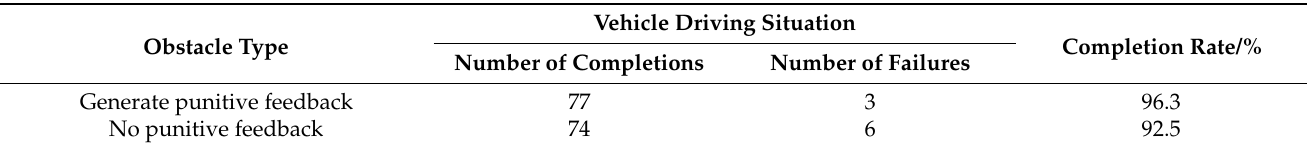
Table 5. Different types of obstacles affecting the vehicle automatic driving performance